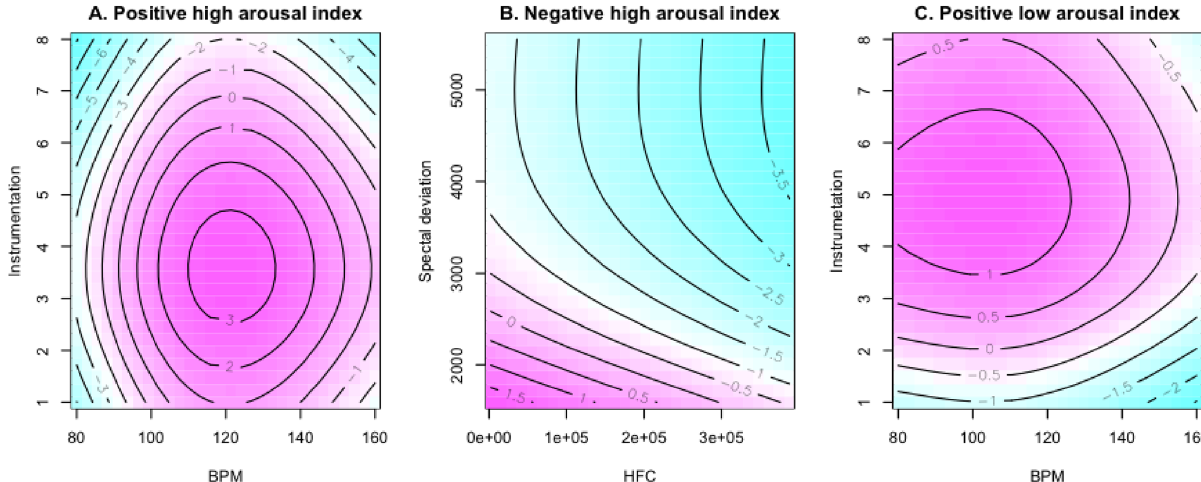
Figure 4. Contour plots for predictive acoustic parameters, derived from a GAM model. The central pink area determines explicit ranges where specific acoustic parameters were related to each emotional response ( A ). Positive high arousal index. Pulse values between 110 and 130 BPM, with 3 and 4 instruments, induced more positive responses. ( B ) Negative high arousal index. A combination of any HFC values, with levels of spectral deviation < 3000 were associated with higher values for this index. ( C ) Positive low arousal index. Pulse values < 120 bpm and 4 to 6 instruments were associated with emotional responses included in this index.